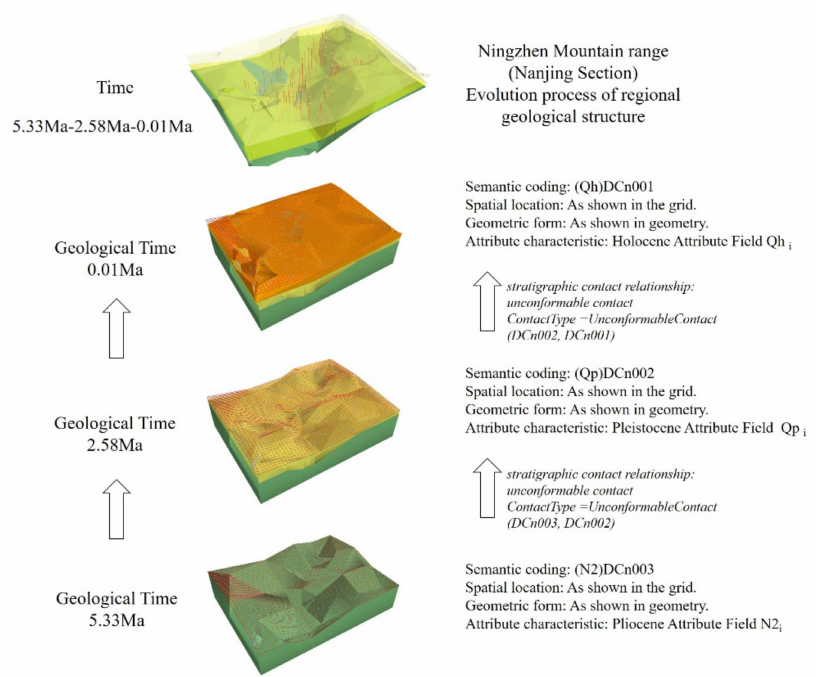
Figure 7. Evolution of the regional geological structure in the Ningzhen Mountain (Nanjing